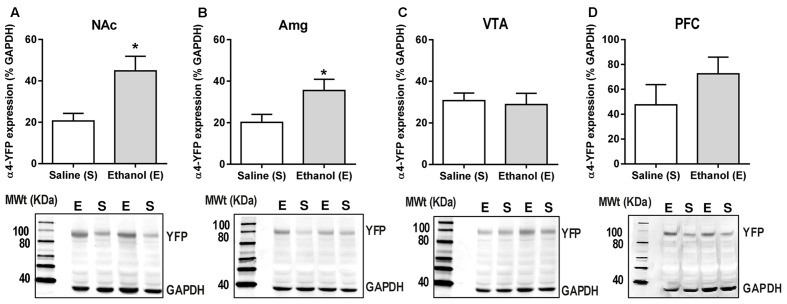
Acute ethanol exposure significantly increases levels of α4 subunit in the nucleus accumbens and amygdala but not in the ventral tegmental area and prefrontal cortex. (A,B) The level of YFP was quantified 20–22 h post-ethanol exposure using western Blot analysis. Data are presented as mean k counts for YFP expressed as a percentage of GAPDH k counts ± SEM (two-tailed unpaired t-test with Bonferroni-Sidak’s correction for multiple analysis (A) NAc ∗p = 0.034, n = 8; (B) Amg ∗p = 0.037, n = 7–8; (C) VTA: p = 0.99, n = 4; and (D) PFC: p = 0.69, n = 7–8). Representative western blots showing the level of YFP and GAPDH expression of both saline (S) and ethanol (E) administered α4-YFP mice are shown for each brain region below the corresponding graphs.